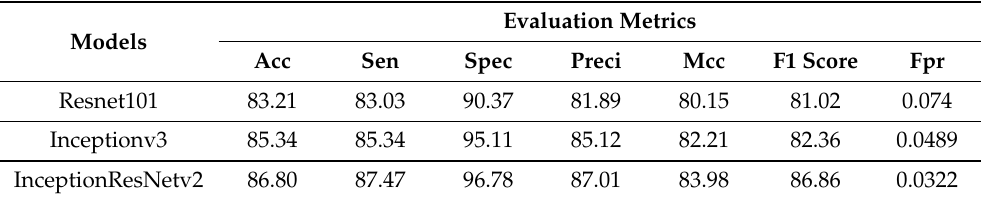
Table 4. Results for pre-trained-MCSVM based models using dataset #1.